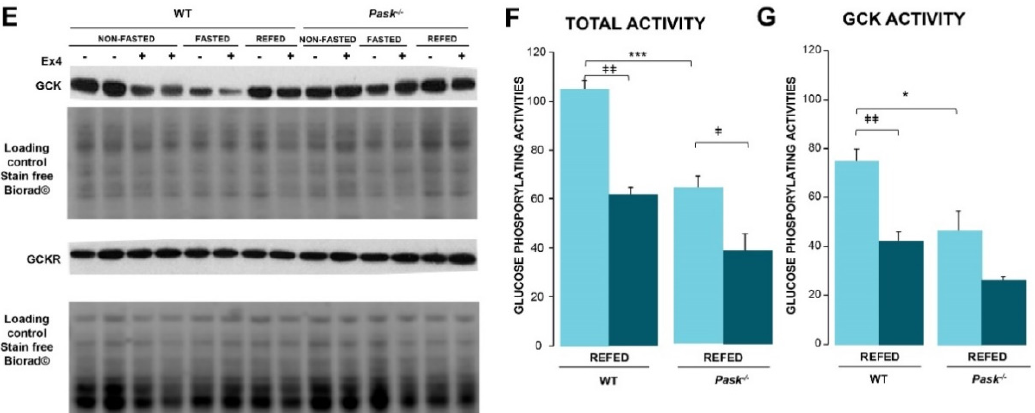
Figure 3. Effects of exendin-4 and PASK deficiency on the response of hepatic Gck, Gckr mRNAs and GCK, GCKR protein levels to fasting/refeeding and glucokinase activity. Quantitative real-time PCR was used to analyze the expression of Gck ( A ) and Gckr ( B ) mRNA levels in the liver from wild-type (WT) and PASK-deficient mice ( Pask − / − ). mRNA levels were measured in 48-h fasted (FASTED) and 3-h refed (REFED) specimens in the absence or presence of exendin-4 treatment and normalized by Rn 18s . Data are shown as mean ± SEM of 3–5 animals per group and expressed as fold-over the fasted condition mean. A Gck mRNA: ‡ p < 0.05, ‡‡ p < 0.01 vehicle vs. exendin-4 by two-way ANOVA followed by Fisher’s LSD test. Immunoblot analysis of GCK ( C , E ) and GCKR ( D , E ) in the liver from wild-type (WT) and PASK-deficient mice ( Pask − / − ). Liver lysates from non-fasted (NON-FASTED), 48-h fasted (FASTED) and 3-h refed (REFED) livers in the absence or presence of exendin-4 (Ex4) treatment were processed for Western blot analysis. A representative blot of 2 prepared blots is also shown ( E ), from which the data shown in the graph were collected ( C , D ). The values were normalized by total protein detected by Stain-Free Biorad© and expressed as fold-over the non-fasted wild-type mice. Data are shown as mean ± SEM of 3–5 animals per condition; * p < 0.05 WT vs. Pask − / − , ‡ p < 0.05, ‡‡‡ p < 0.001 vehicle vs. exendin-4 by two-way ANOVA followed by Tukey post-hoc test. Total glucose-phosphorylating activity assays ( F ) were performed at 30 mM, with low-Km hexokinase (HK) activities at 0.3 mM glucose. GCK activity was obtained by the difference between individual values at high and low glucose ( G ). Liver homogenates from 3-h refeeding after prolonged fasting (REFED) in the absence or presence of exendin-4 (Ex4) treatment from wild-type (WT) and PASK-deficient mice ( Pask − / − ). ( F ) Total glucose-phosphorylating activity and ( G ) glucokinase (GCK) activities are shown as mean ± SEM of 3–5 animals per group and expressed as a percentage of the control mean; * p < 0.05, *** p < 0.001 WT vs. Pask − / − and ‡ p < 0.05, ‡‡‡ p < 0.001 vehicle vs. exendin-4 by two-way ANOVA followed by Tukey post-hoc